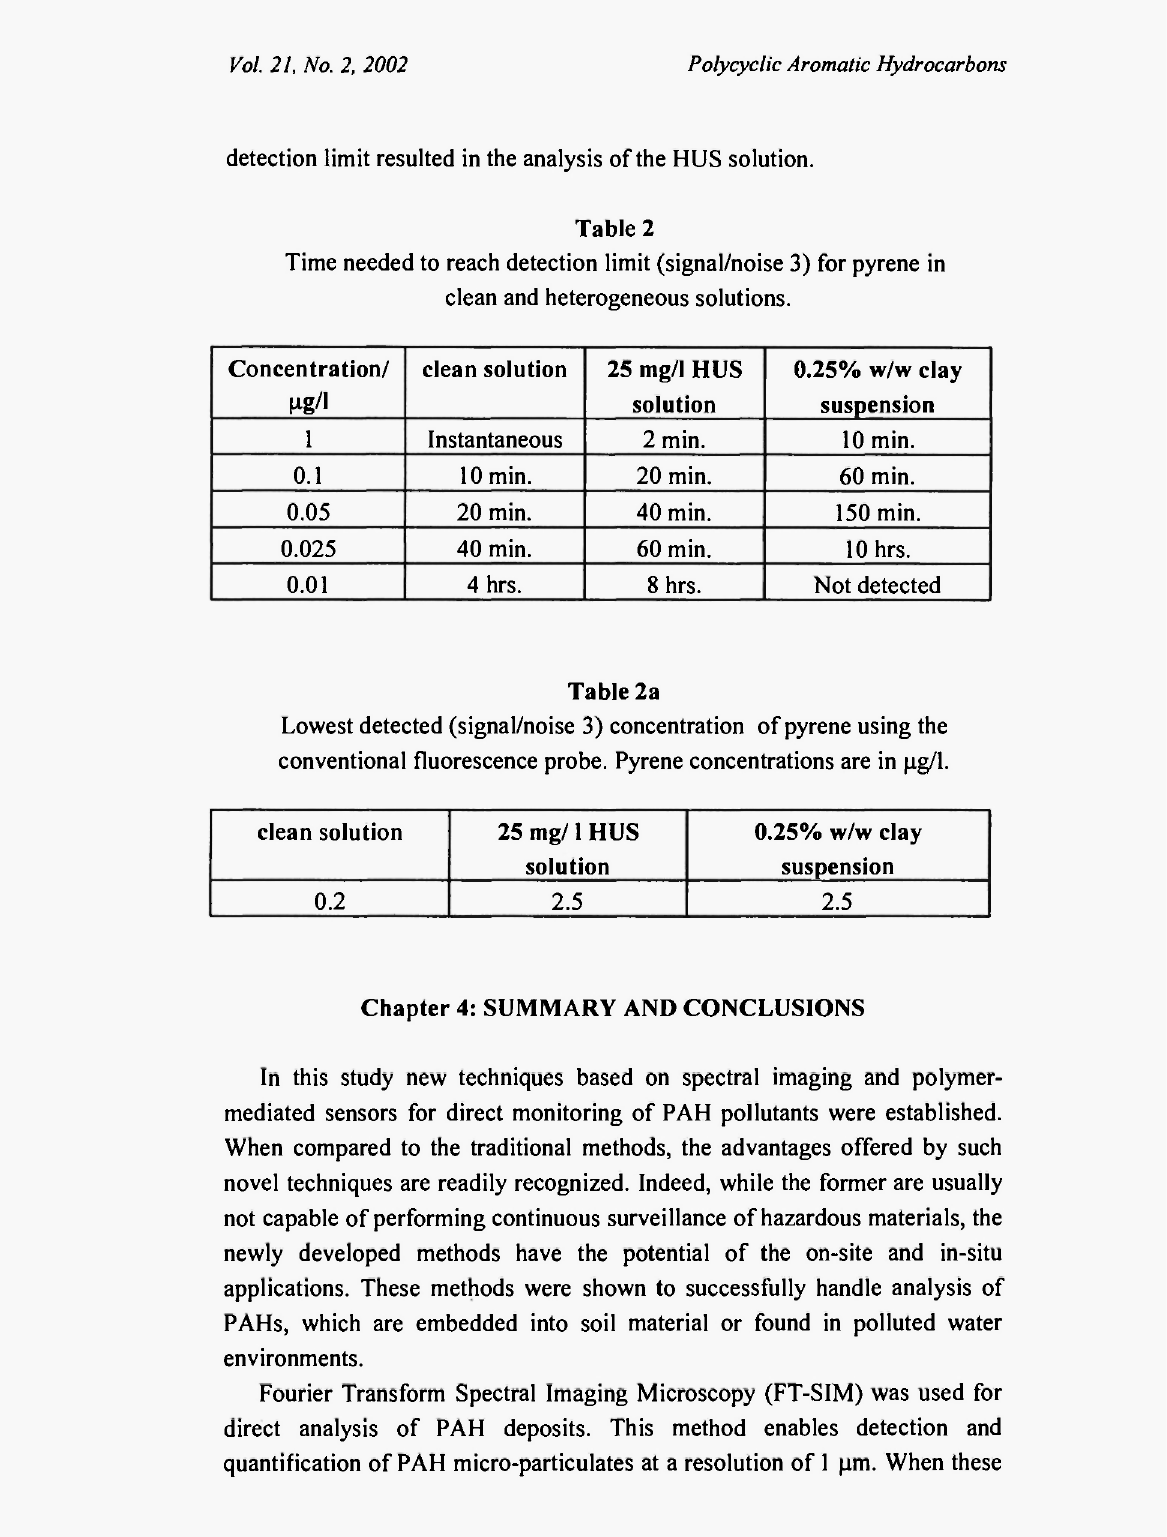
Time needed to reach detection limit (signal/noise 3) for pyrene in clean and heterogeneous solutions.